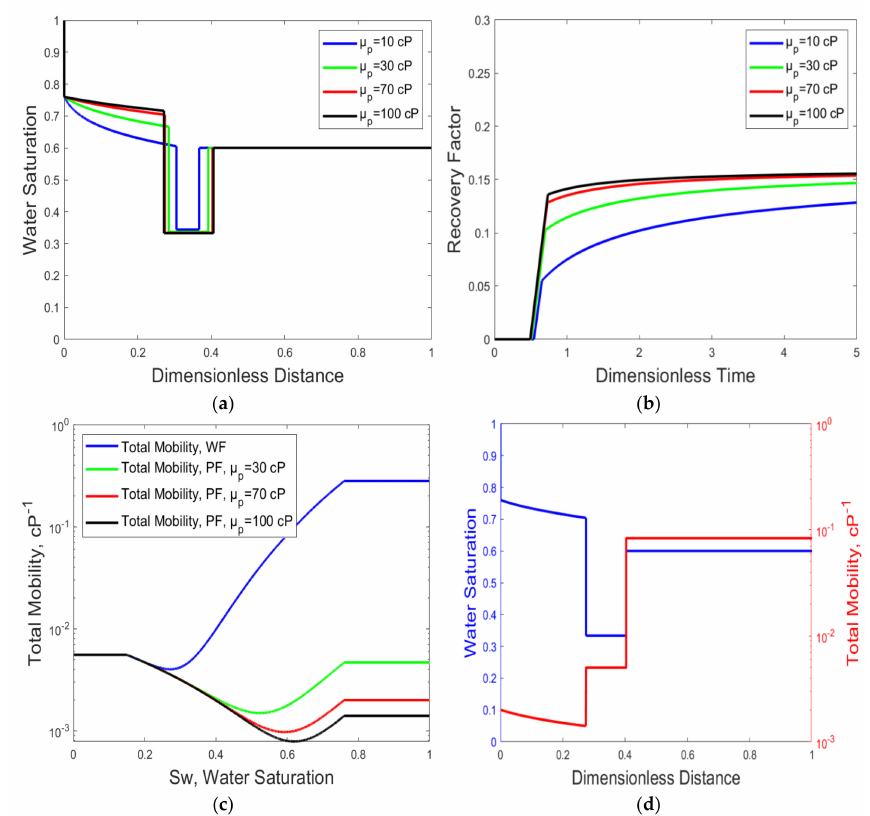
Figure 17. ( a ) Comparison of shock front for water flooding and polymer flooding; ( b ) Incremental oil recovery history during continuous tertiary polymer flooding; ( c ) Total mobility as a function of water saturation for di ff erent polymer viscosity; and ( d ) Total mobility calculated during polymer flooding, t D = 0.20 PV, µ p = 70 cP, µ o = 72